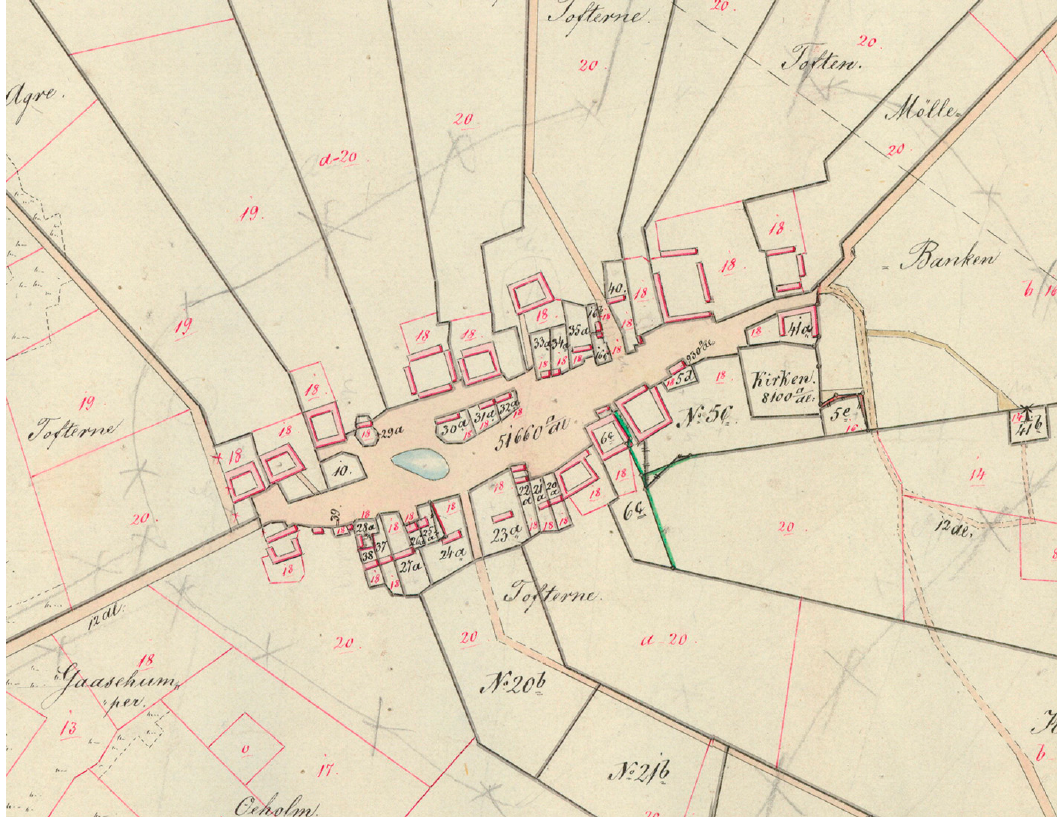
Figure 13. Section of map from 1862 showing the former organisation of the village.